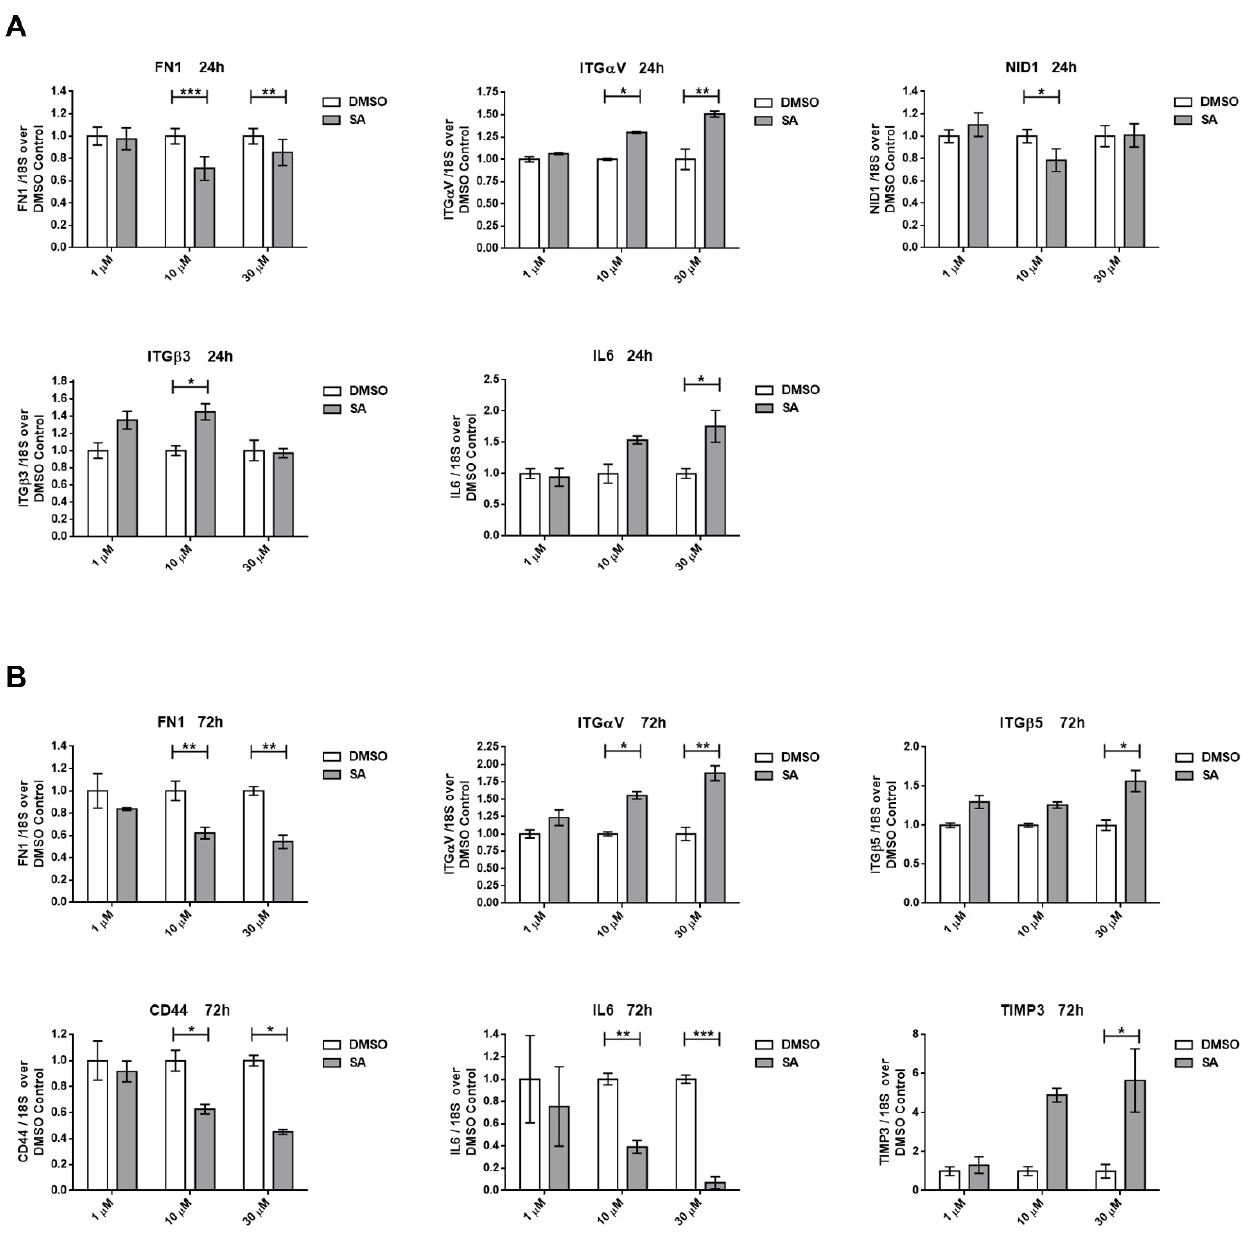
Figure 6. Altered gene expression signature of A549 cells after SA treatments. A broad panel of genes related to cell adhesion and extracellular matrix composition and remodeling was tested. ( A ) Significant gene expression of control and A549 with SA treated for 24 h. ( B ) Significant gene expression of control and A549 with SA treated for 72 h. Data represent mean ± SEM gene expression with respect to the 18S-housekeeping gene of three different experiments. * p < 0.05, ** p < 0.01, *** p < 0.001.